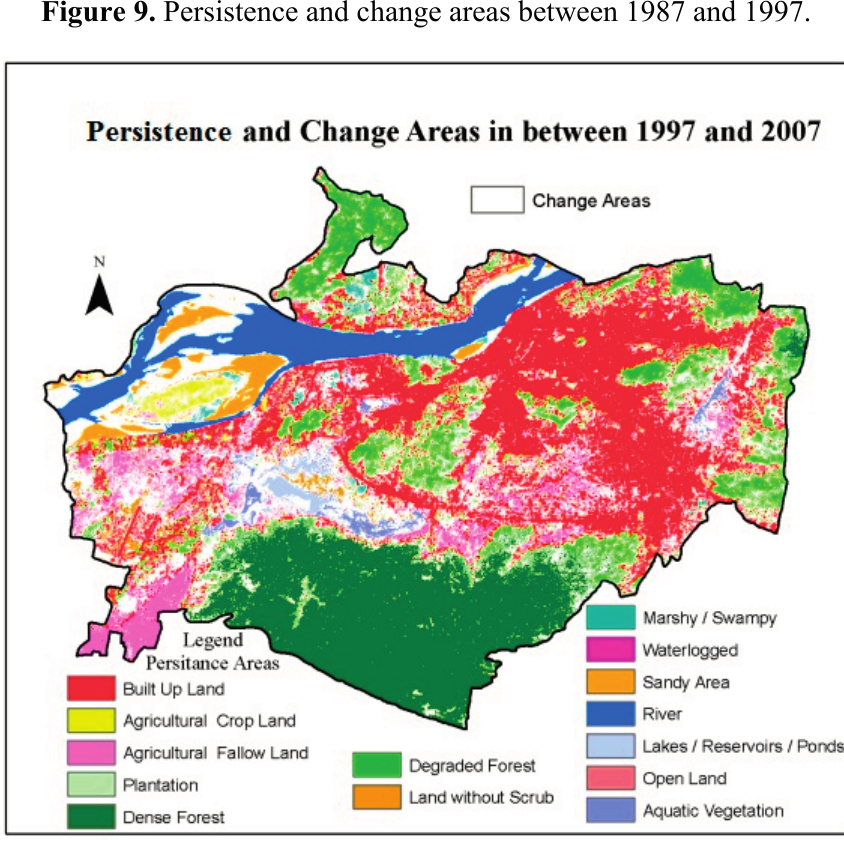
Figure 10. Persistence and change areas between 1997 and